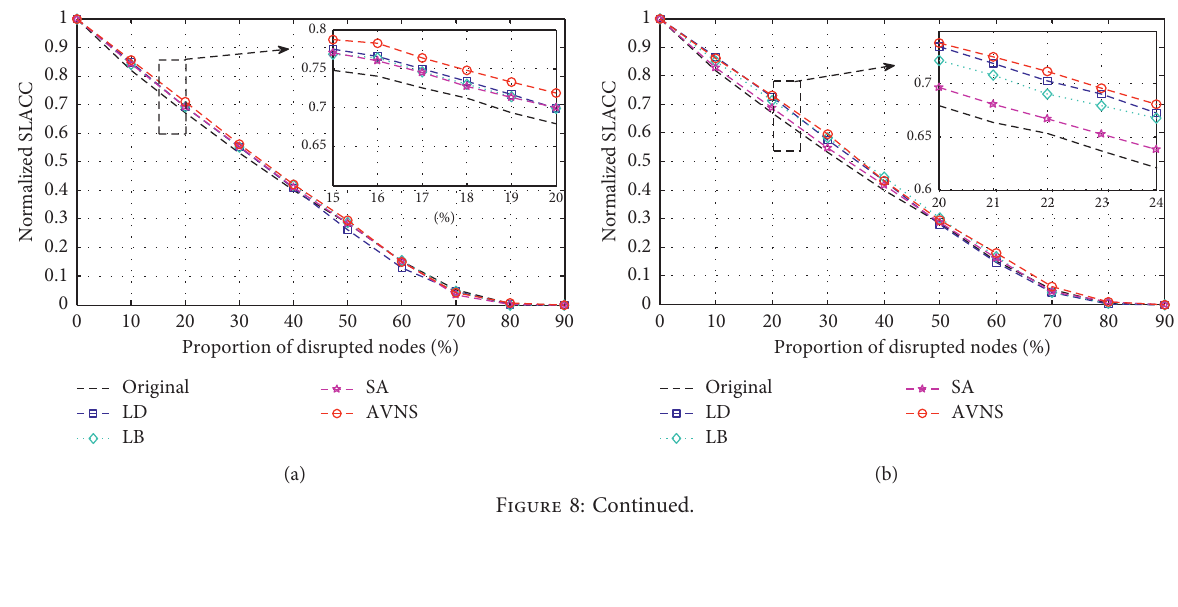
� 5%. (b) f � 10%. (c) f � a a a